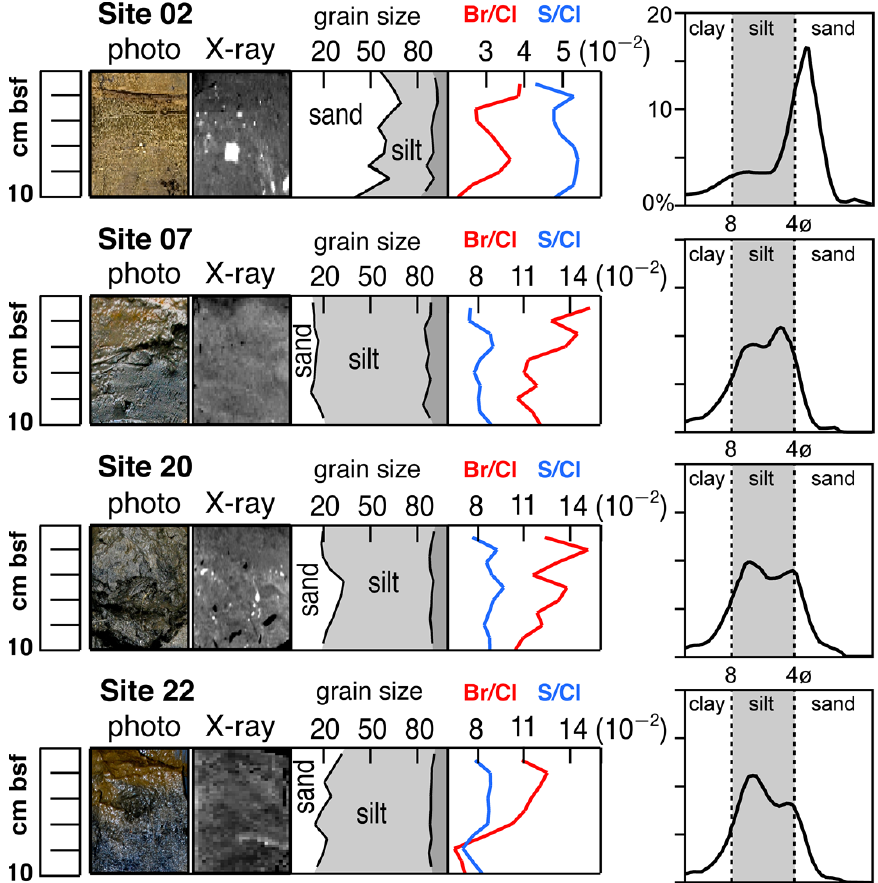
Figure 2. Sedimentological information of the studied cores including sediment photographs, X- rays (white = high density), and the down core distribution of grain size and compositional (XRF) characteristics. On the right side, we report the mean frequency curves of grain size distribution for each studied interval.